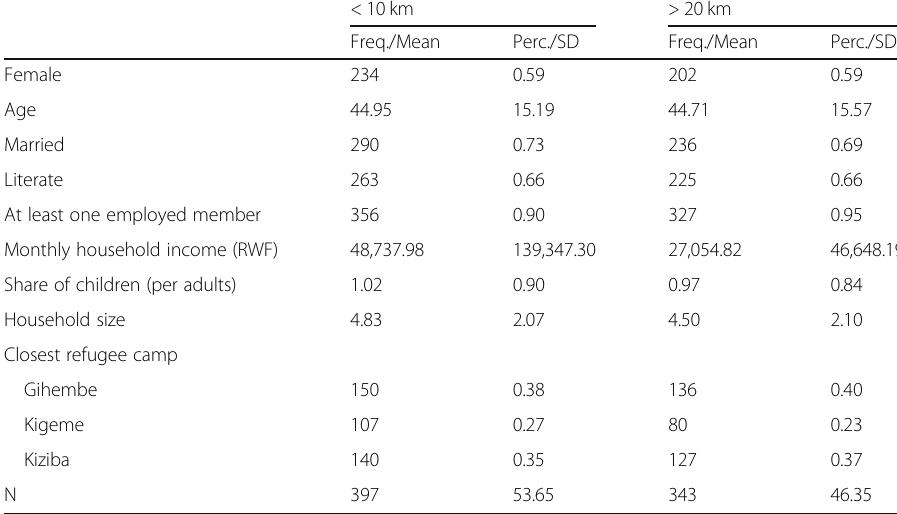
Table 2 Summary statistics of the sample, by distance from a refugee camp < 10 km > 20 km Freq./Mean